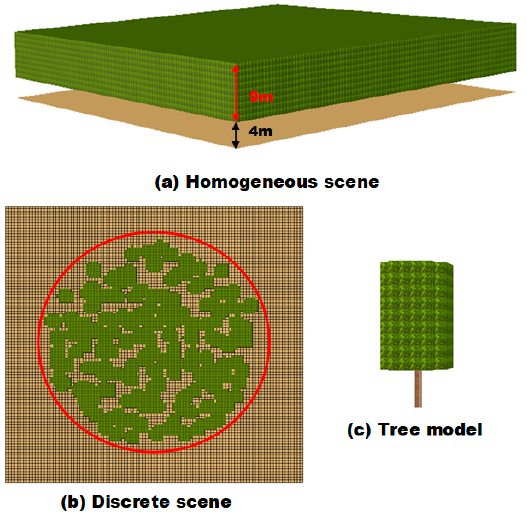
Figure 3. Overview of the realistic structure scenes constructed in the DART model. ( a ) is a homogeneous turbid scene that is composed of a cube plant canopy and a horizontal ground; ( b ) is a discrete individual tree scene that comprises a 3-D tree model; ( c ) is the 3-D tree model used in the discrete scene.